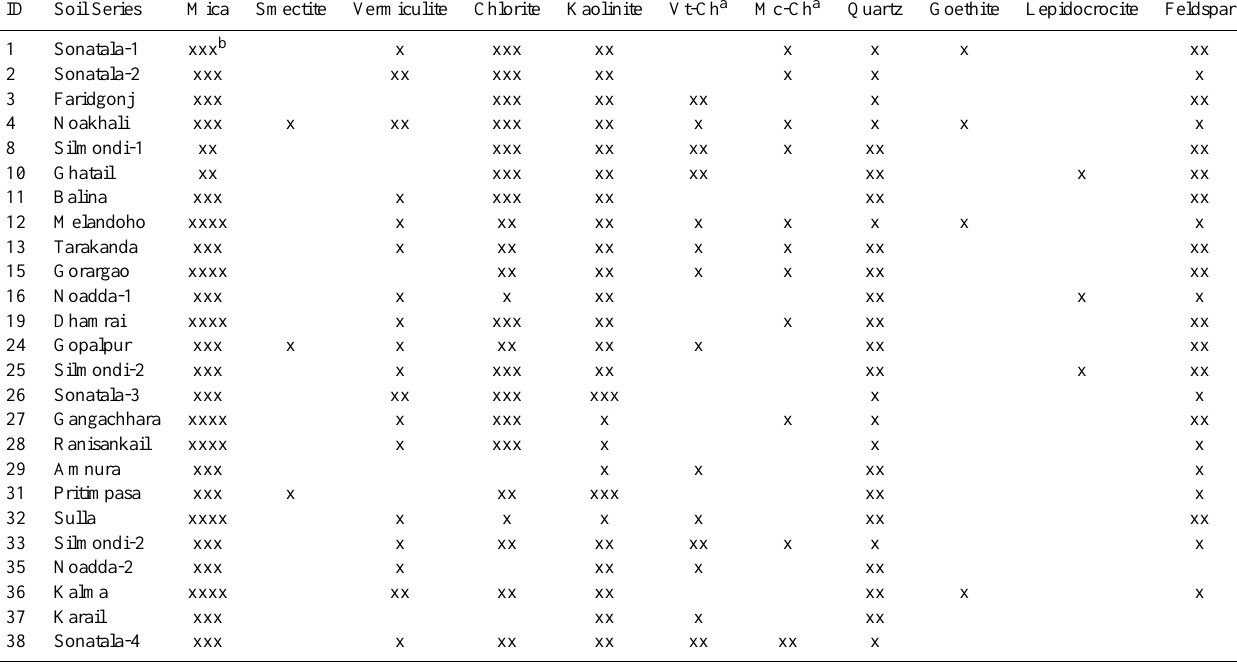
Table 2. Clay fraction mineralogical composition of sampled agricultural fields in Bangladesh (data from Kader et al., 2013). ID Soil